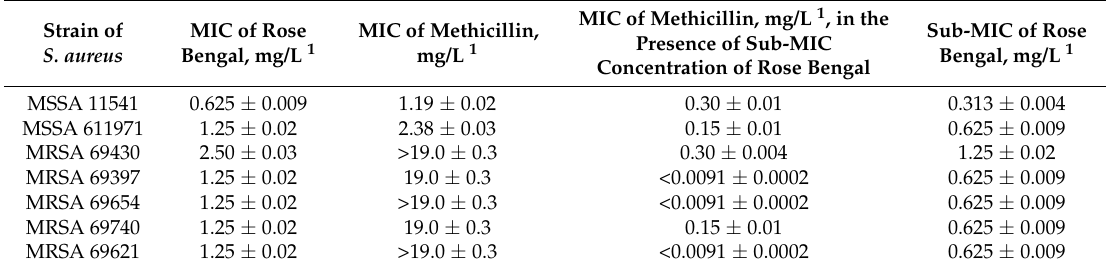
Table 1. MIC of Rose Bengal, of methicillin alone and in the presence of sub-MIC concentrations of Rose Bengal under illumination for MSSA and